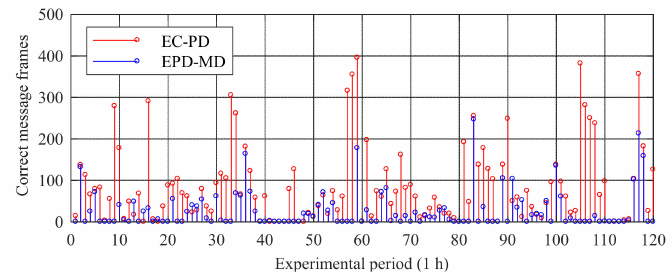
Figure 12. Statistical results of experimental